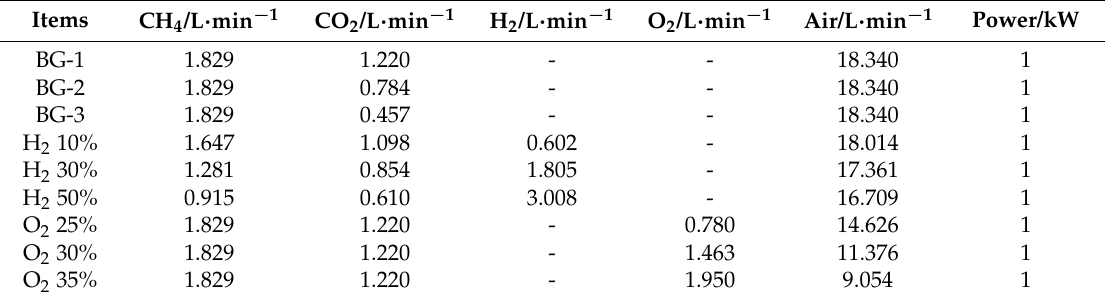
Figure 1. Geometry of the combustion chamber (not to scale). Table 1. Composition of biogas flames at H 2 -enriched and O 2 -enriched conditions.